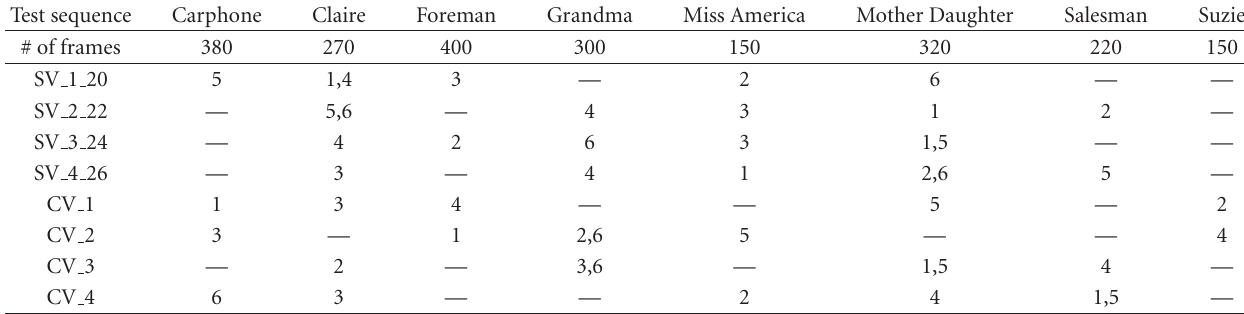
Table 1: Construction of the test